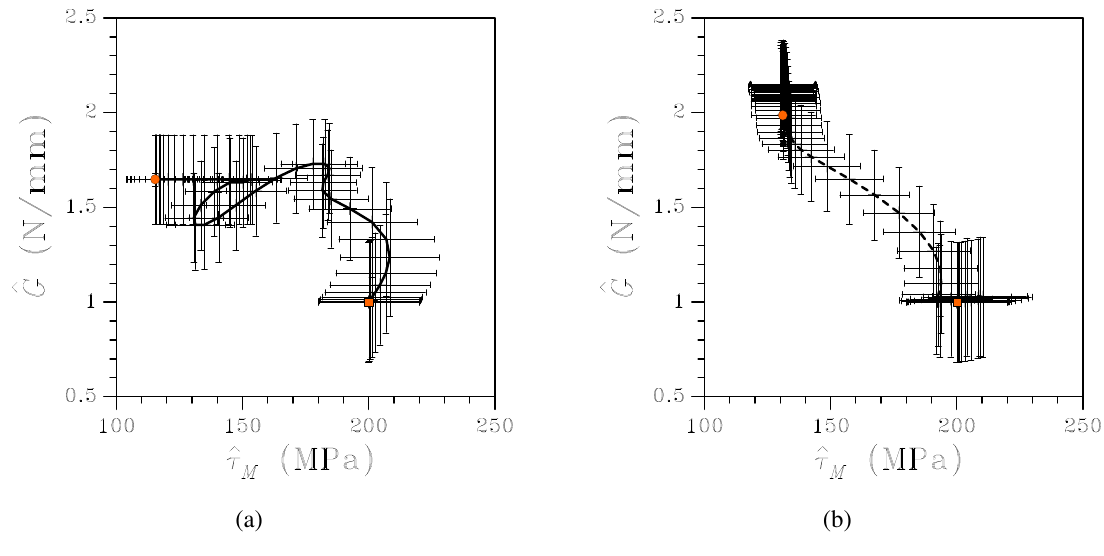
Figure 6. Impact on a 7-layer composite [13]: evolution in time of estimated inter-laminar strength τ and toughness G , and of the relevant covariances (a: PWL law; b: L-E law). In M the plots the squares denote the common initial guess ˆ ϑ estimates at time t = 10 µ N